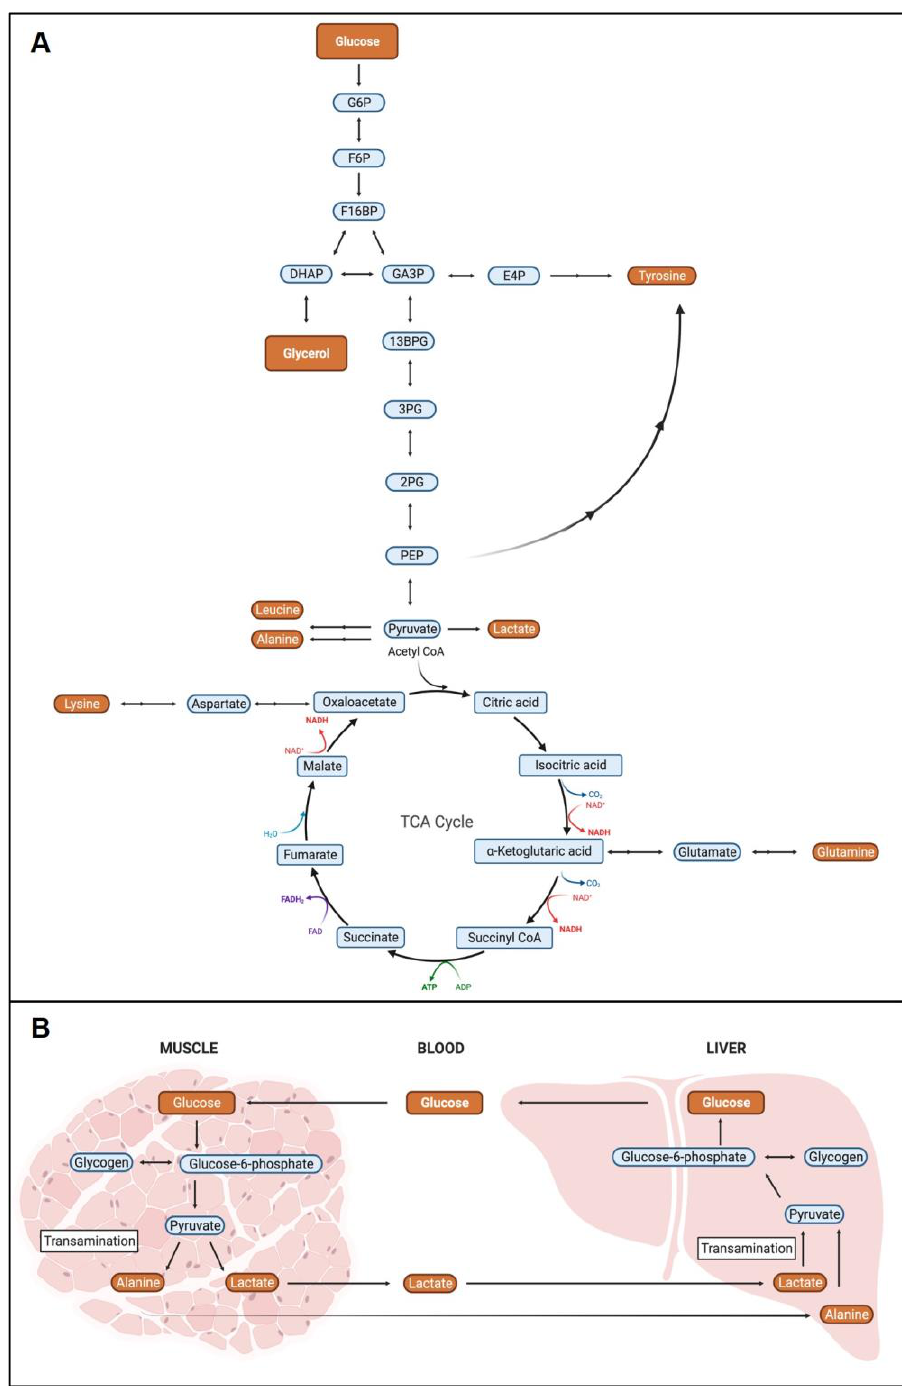
Figure 2. Dysregulated Male LRRK2 PD Metabolic Pathways. ( A ) Altered metabolites in male LRRK2 PD are enriched for amino acids and metabolites associated with glycolysis and gluconeogenesis. ( B ) Altered metabolites glucose, alanine, and lactate are central components of the glucose-alanine and Cori cycle important for supporting gluconeogenesis in the liver. Detected differential metabolites are highlighted in orange boxes. Double arrows represent multiple enzymatic transformational steps. Abbreviations: G6P; Glucose-6-phosphate, F6P; Fructose-6-phosphate, F16BP; Fructose 1,6-biphosphate, DHAP; dihydroxyacetone phosphate, GA3P; Glyceraldehyde-3-phosphate, 13BP; 1,3-Biphosphoglycerate, 3PG; 3-Phosphoglycerate, 2PG; 2-Phosphoglycerate, PEP; Phosphoe- nolpyruvate.